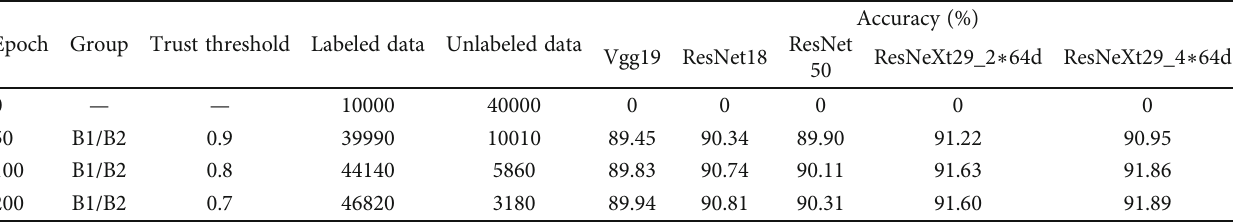
Table 2: Record of semi-supervised training.